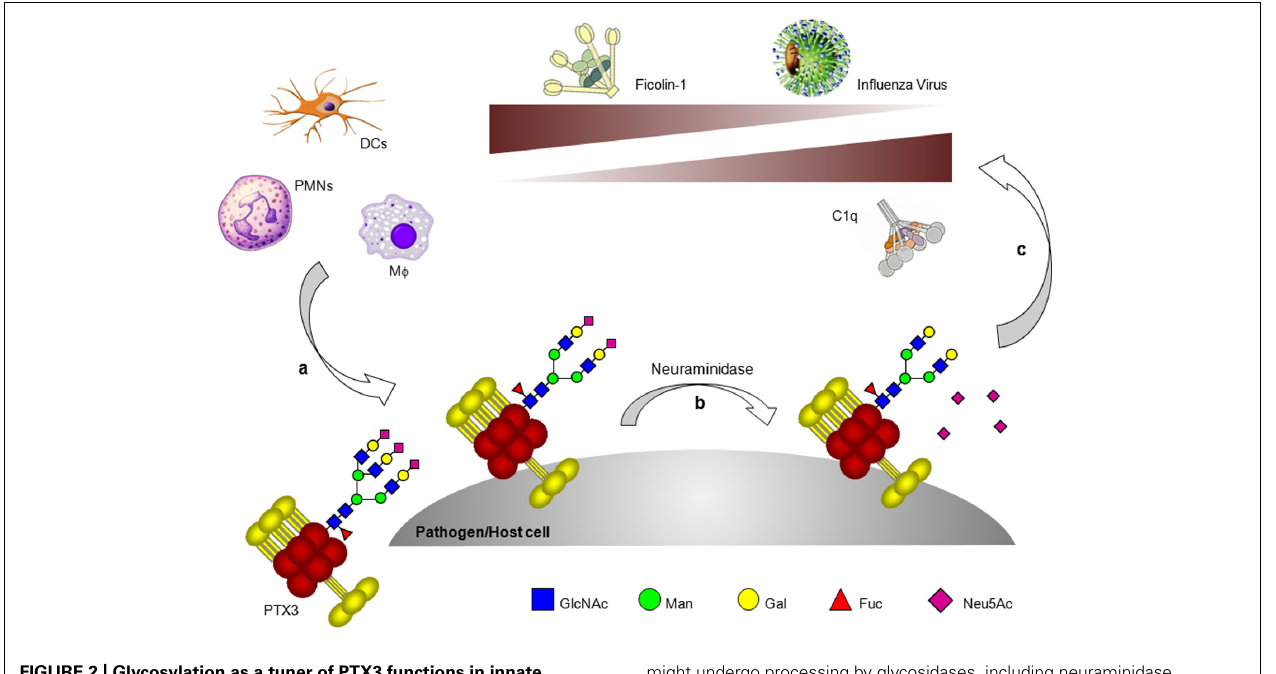
FIGURE 2 | Glycosylation as a tuner of PTX3 functions in innate immunity. A number of both somatic and immune cell types produce PTX3 at sites of infection/inflammation.The glycosylation status of PTX3 (e.g., branching and sialylation) might change depending on cellular source and inducing stimuli (a) . In addition, the protein oligosaccharides